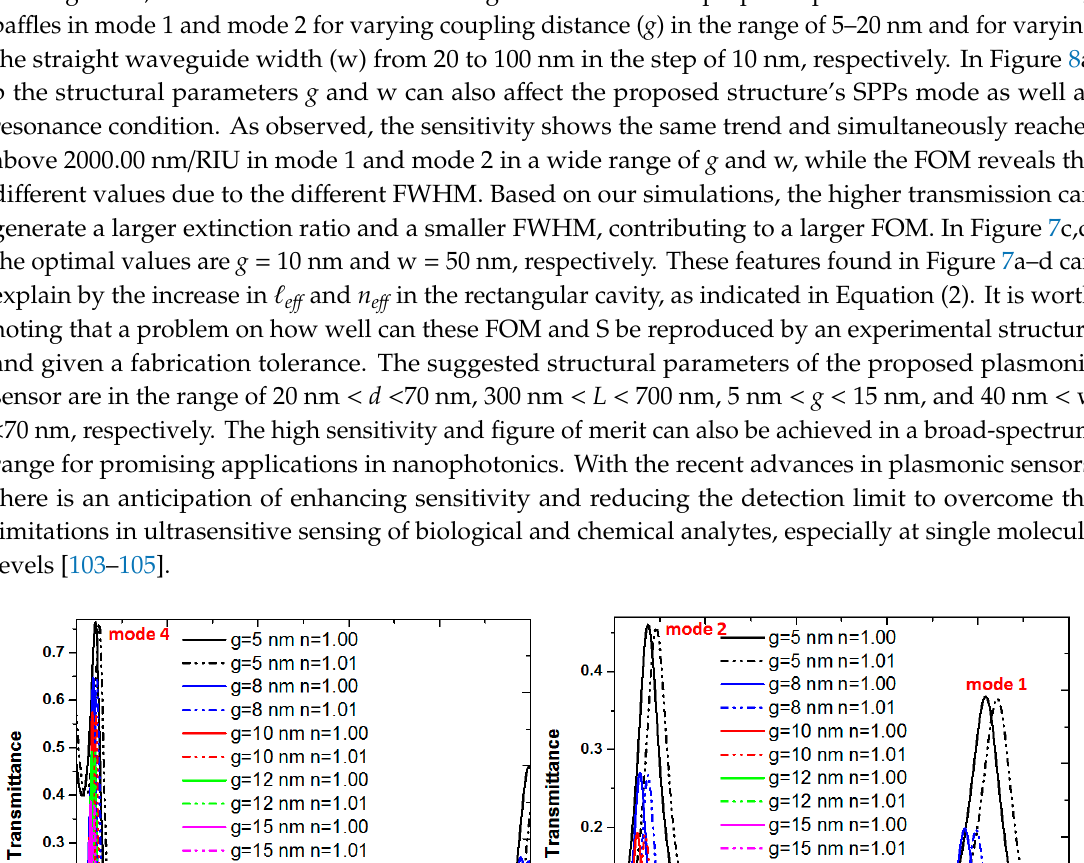
Figure 8. Transmittance spectrum of the proposed plasmonic filter of ( a ) mode 3 and mode 4 and ( b ) mode 1 and mode 2 versus different coupling distances ( g ) and different refractive indices ( n ). The g values are varied from 5, 8, 10, 12 to 15 nm and n values change from 1.00 to 1.01.